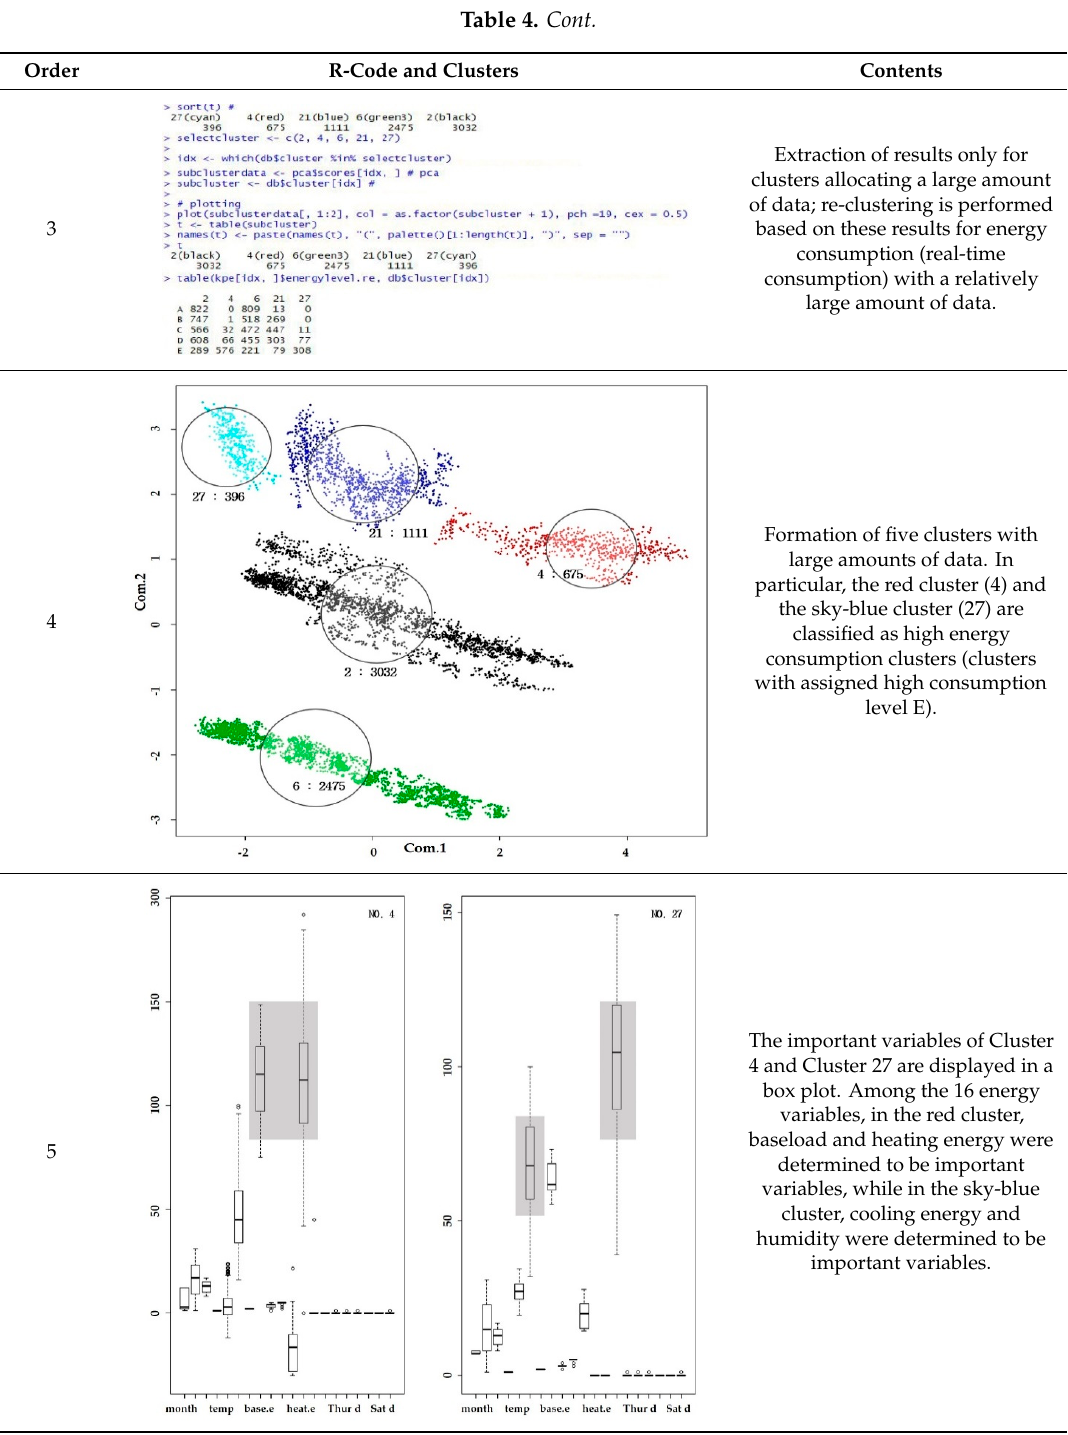
Figure 2. Schematic representation of the research process.